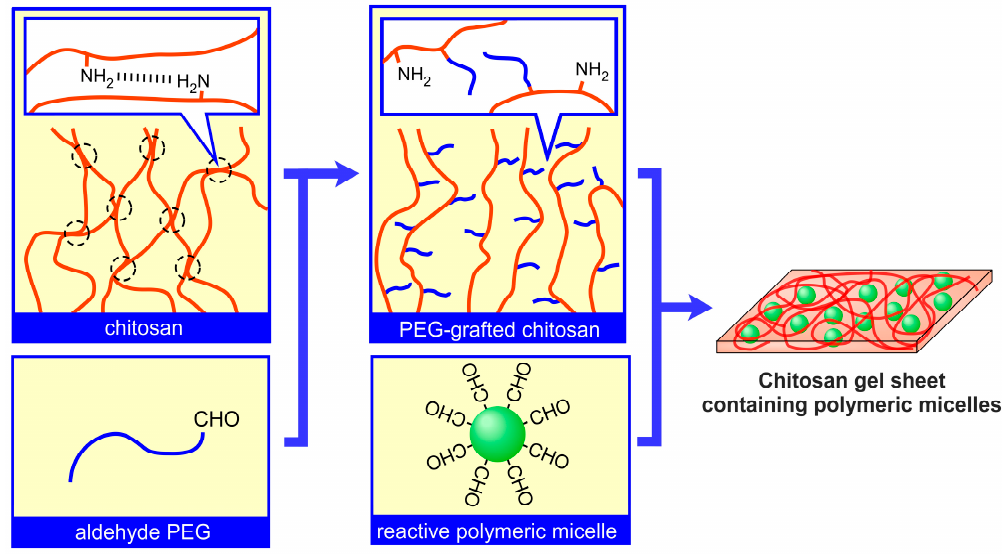
Figure 1. Hydrogel sheet consisting of PEG-grafted chitosan and crosslinkable polymeric micelles.